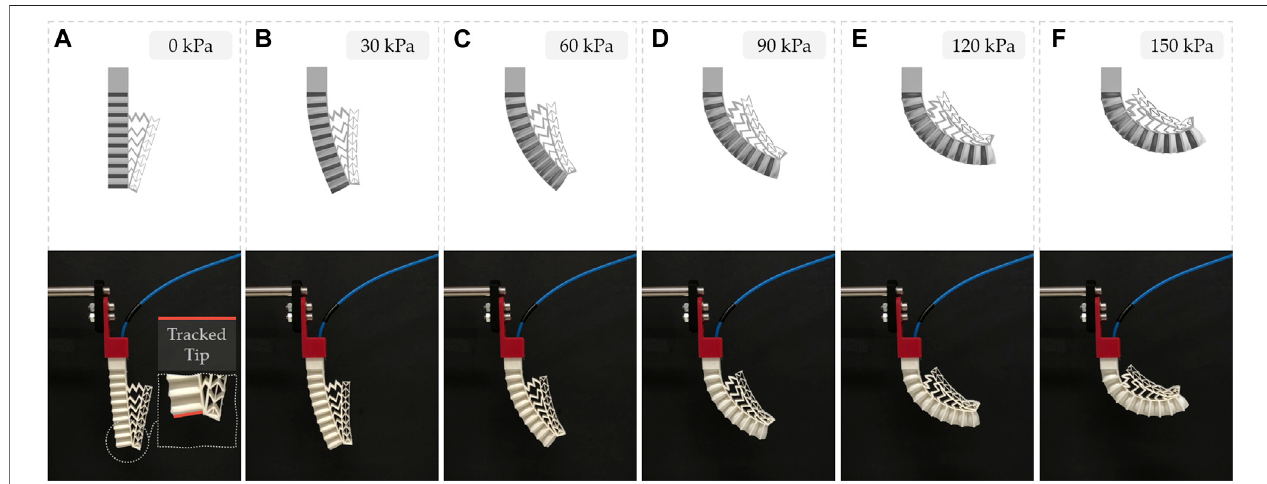
Frontiers in Robotics and AI |